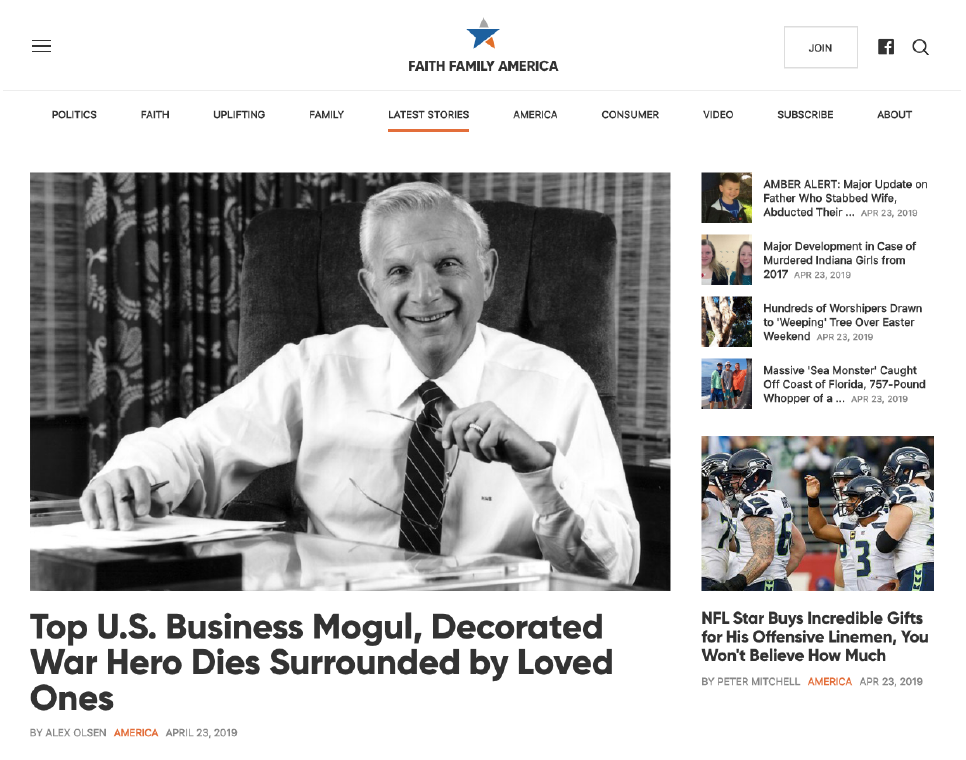
Figure 4: Faith Family America’s front page, capture 23 April